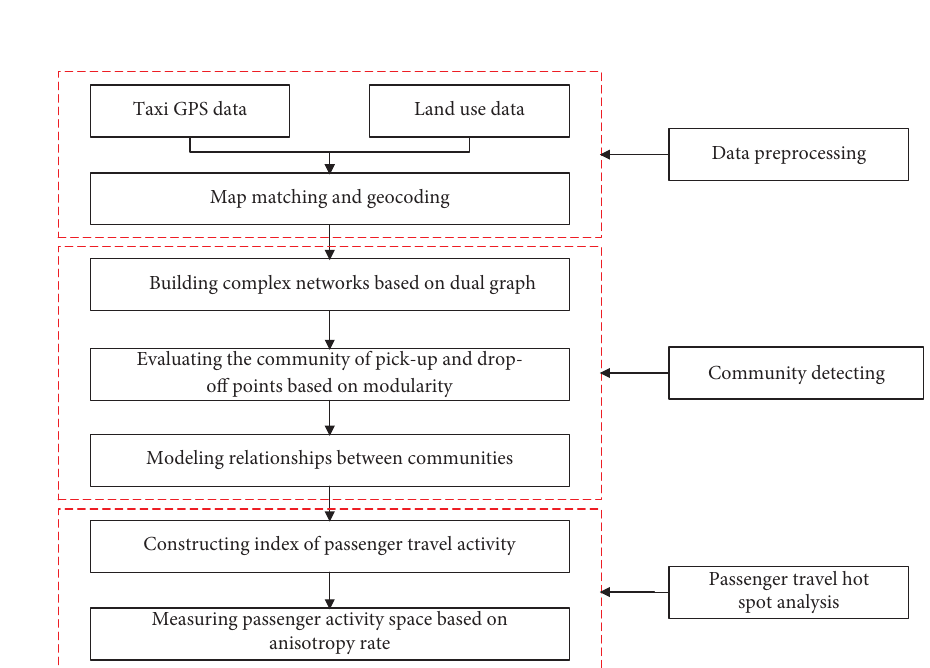
Figure 1: Study area map.